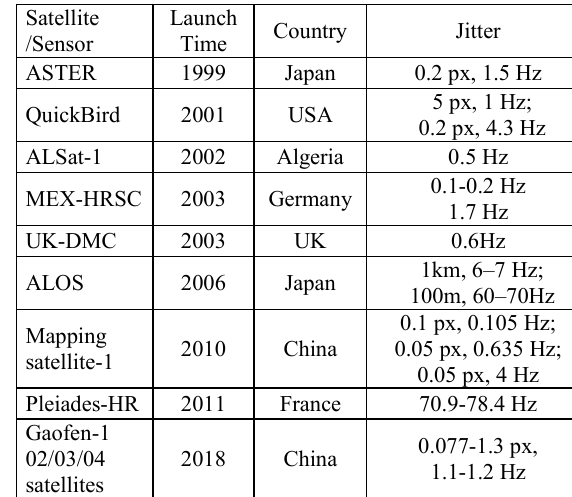
Table 1. Examples of satellite